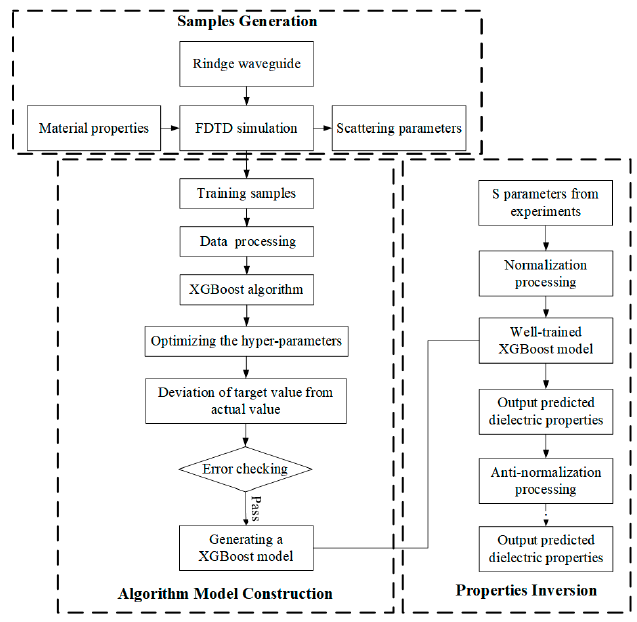
Figure 3. Inversion flow chart.